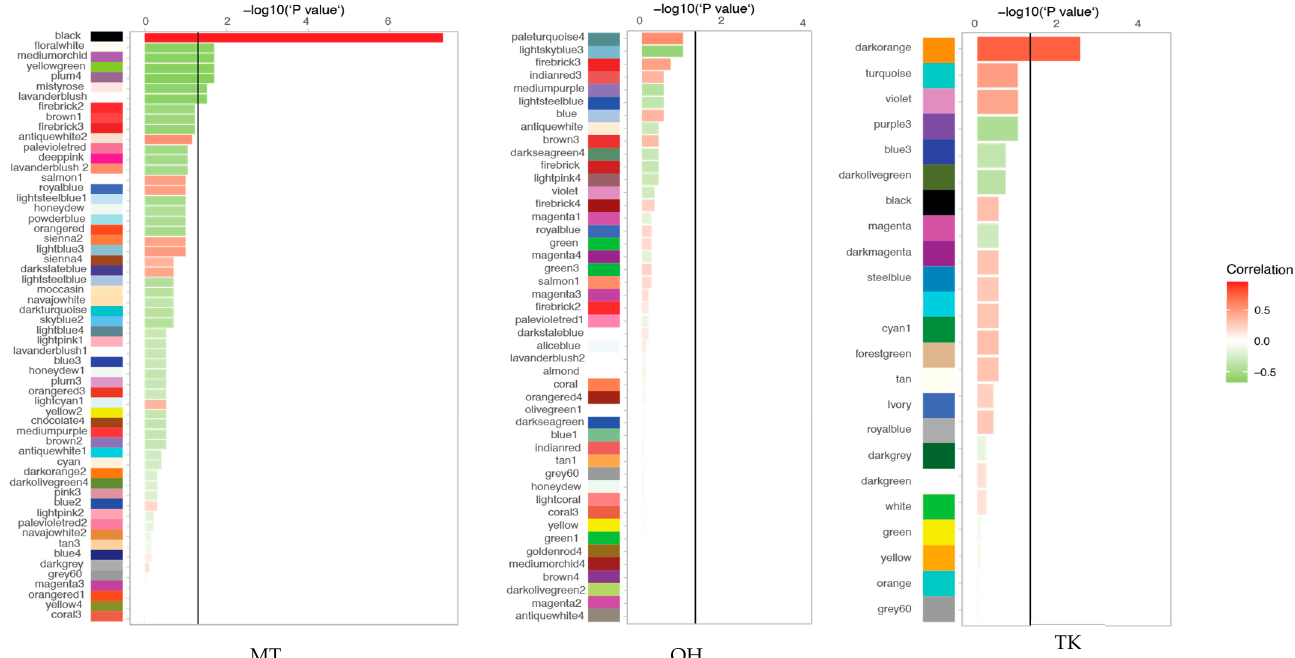
Figure 4. Module trait relationship plots. Colour coded gene modules identified by WGCNA for each dataset, black line depicts cut-off for significance using − log10 p value ( p < 0.05). Bars are coloured in red or green according to correlation value, red being positive correlation and green negative correlation between trait and gene expression (wild type vs. mu- tant).